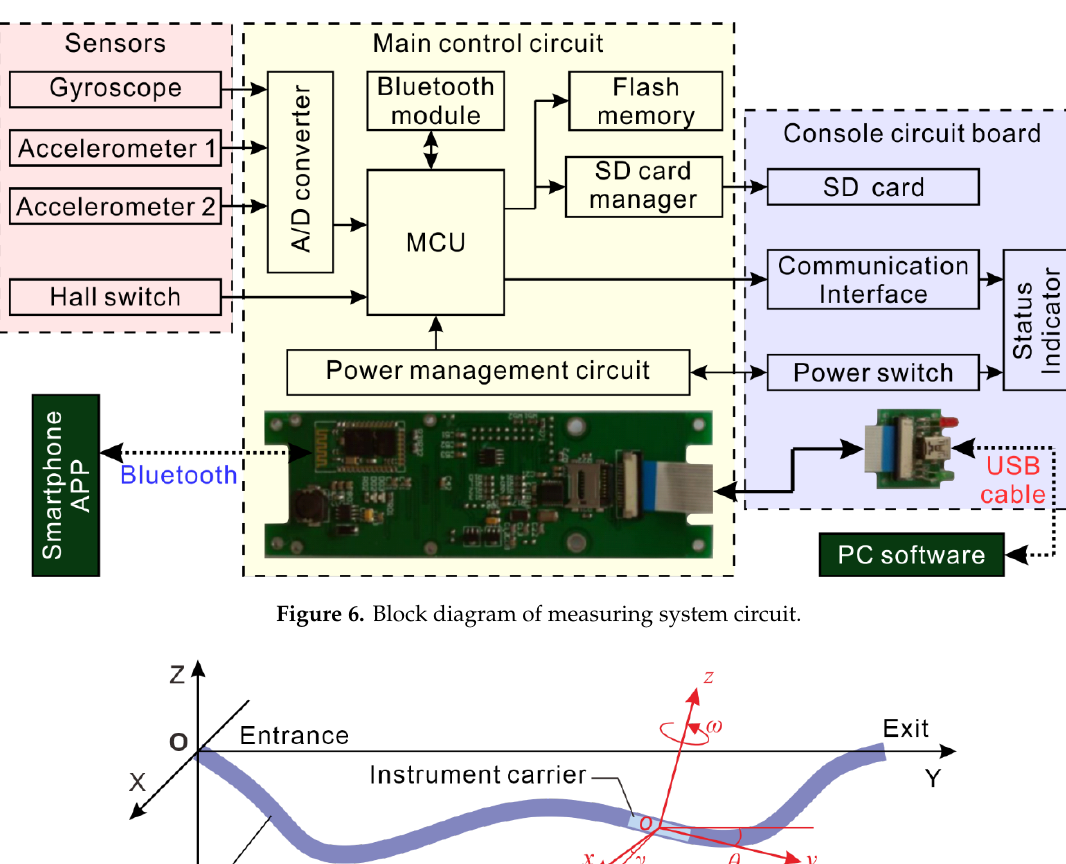
Figure 7. Reference coordinate system (OXYZ) and instrument coordinate system ( oxyz ).